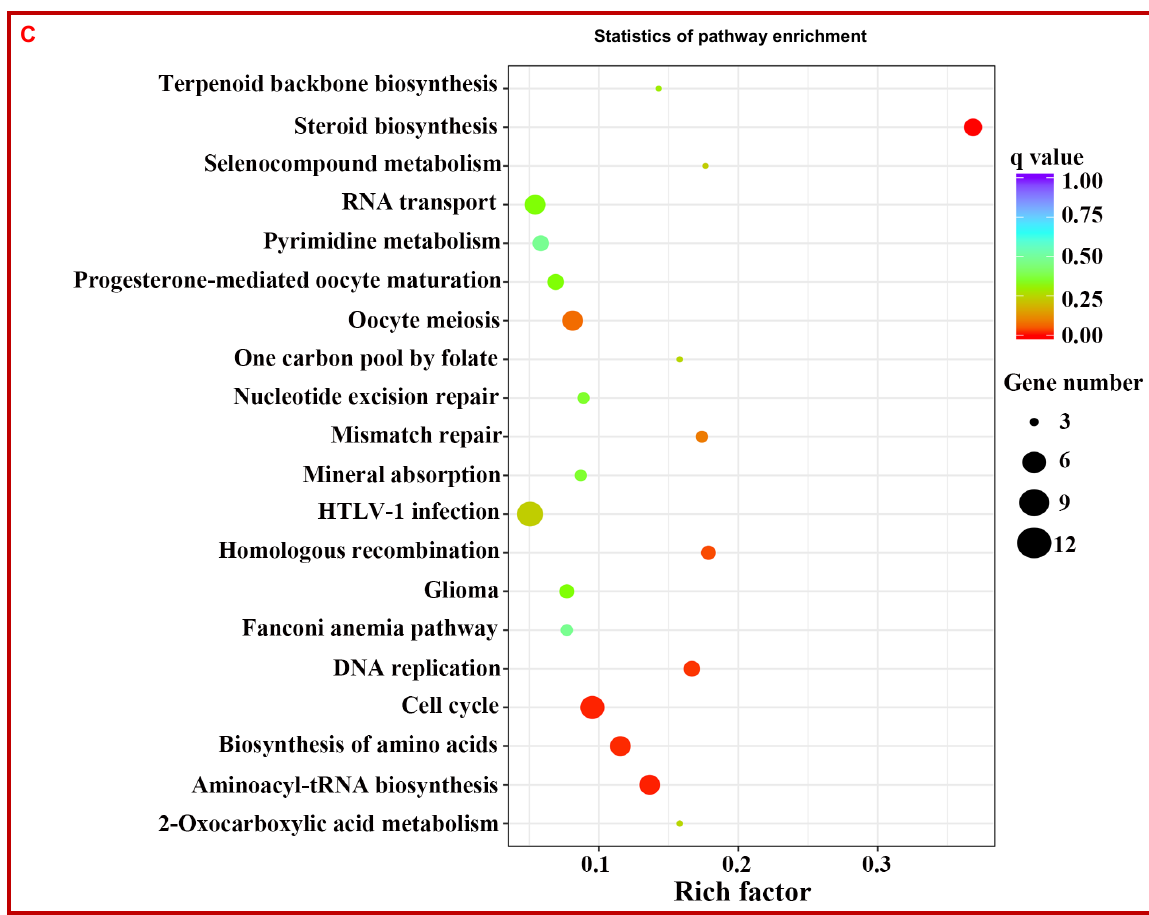
Figure 2: Differential gene expression analysis after treated with P. cocos . Volcano plots of differentially expressed genes between treated lycorine with control (A). GO enrichment analysis of regulated differentially expressed genes in P. cocos -treated cells. His- tograms of the top 30 enriched GO terms. Enriched items were selected with a corrected. p -Value 0.05 (B). KEGG pathway enrich- ment analysis of regulated differentially expressed genes in P. cocos treated-cells (C). Scatter plots of the top 20 enriched KEGG pathway terms. Enriched items were measured by the rich factor, q value (q<0.05) and the number of genes